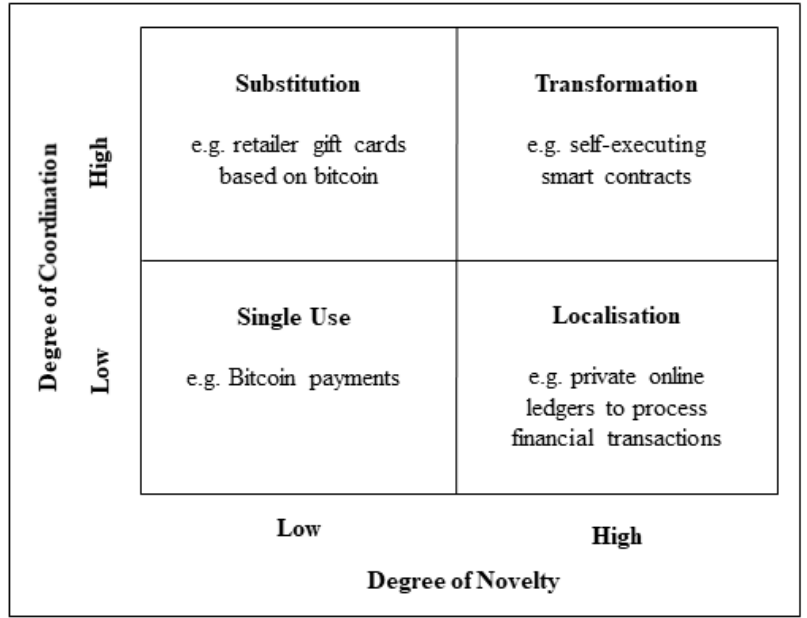
Figure 1. Blockchain transformation phases. Source: adapted from Iansiti and Lakhani [11].